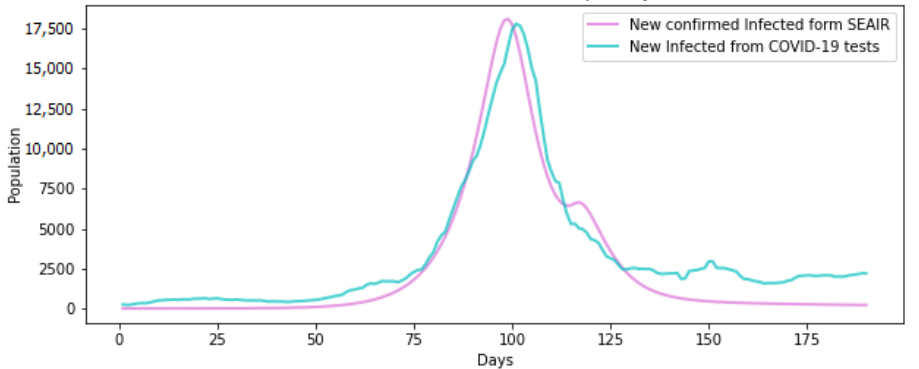
Figure 3. Example of newly infected persons per day data and SEAIR adjusted curve in Belgium. Second